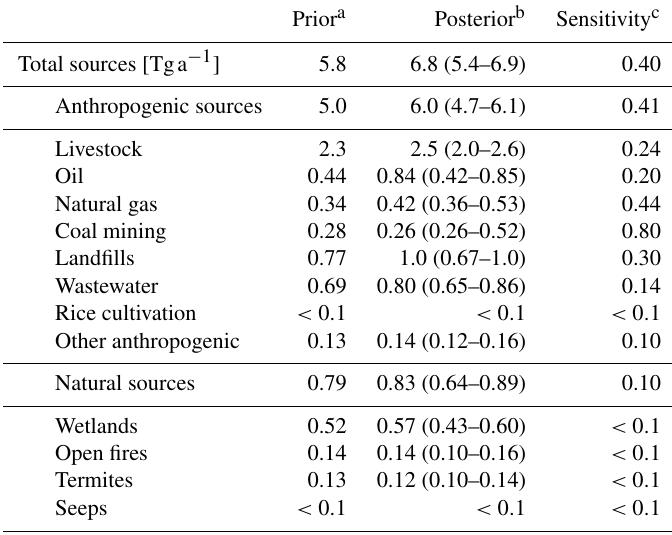
Table 1. (c) Mean 2010–2017 methane emissions for